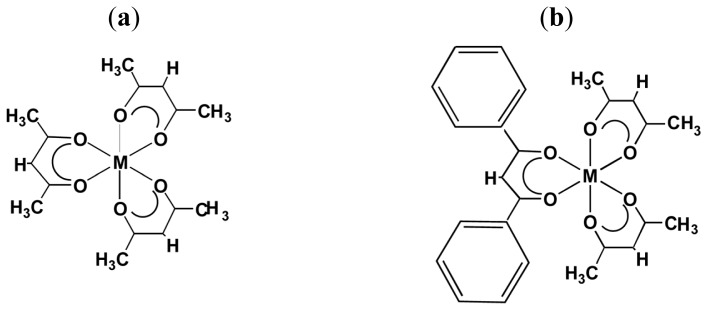
(a) [M(III)(acac)3] (acac = acetylacetonato, M = Ru, Cr, Co, Rh, Ir and Al); (b) [M(III)(acac)2(dbm)] (M = Ru, Cr, and Co) (modified from [15]). (a) (b)